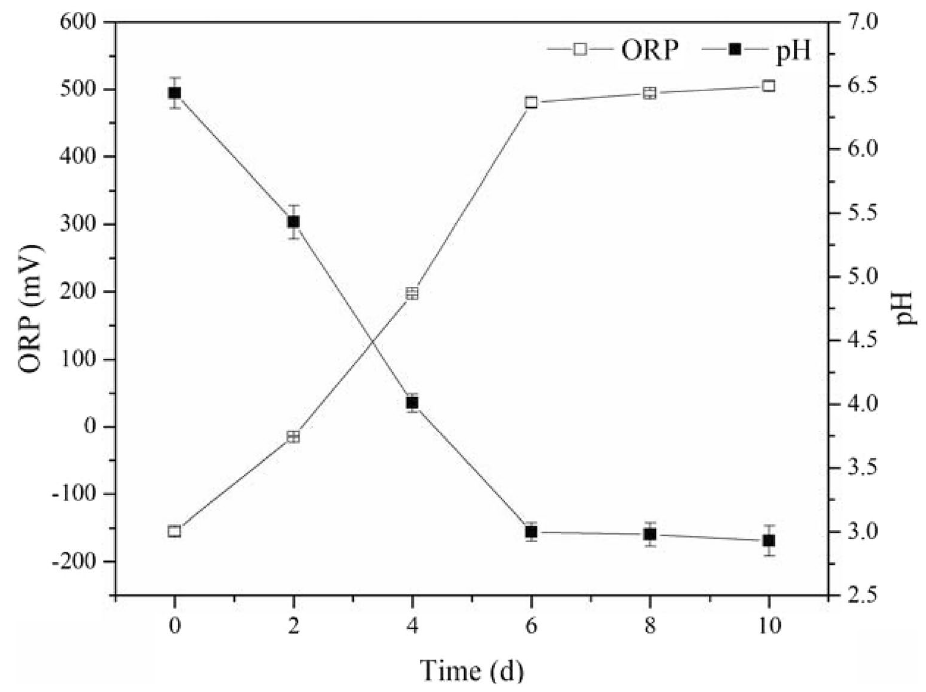
Figure 1. Variation of pH and ORP during bioleaching